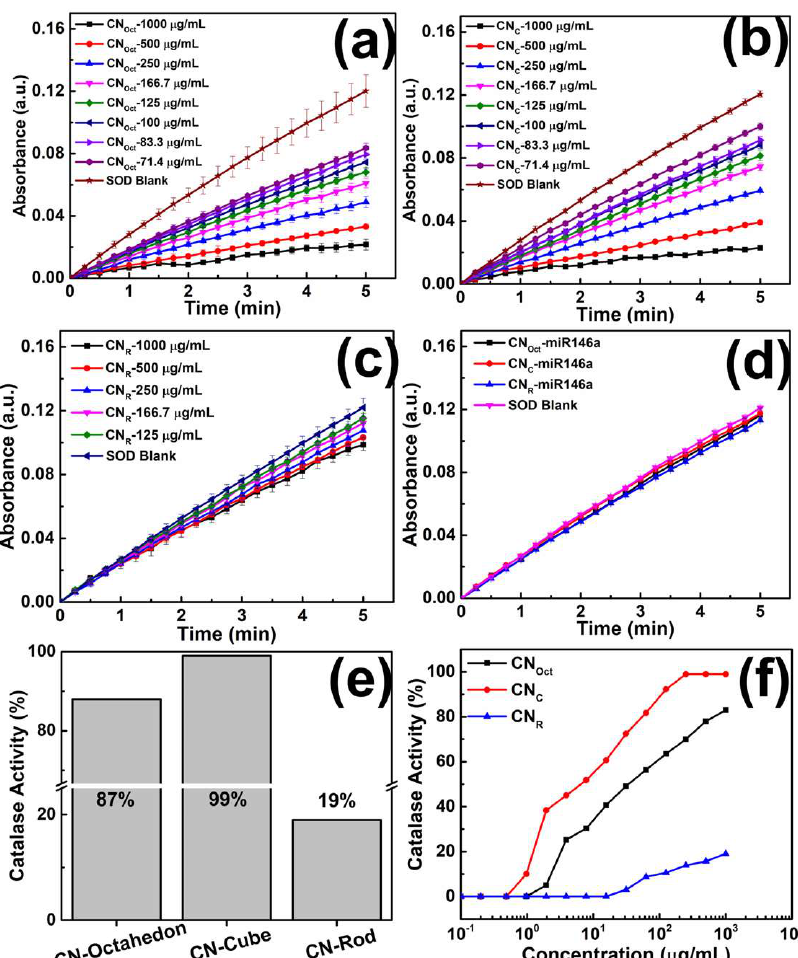
Figure 4. Superoxide dismutase (SOD) mimetic activity of CeO 2 nanoparticles with different mor- phology at different concentration. Absorbance of sample, respectively, SOD control, CN Oct , CN C , CN R , ( a – c ), respectively, and miR146a conjugated all the samples of CNPs ( d ) at 438 nm is plotted as a function of assay reaction time. Linear fitting was used to measure the slope and calculate the SOD activity. CN Oct exhibits the highest SOD activity. The miR146a conjugated CNPs showed very less SOD activity as compared to bare nanoparticles. It is due to below critical concentration of nanoparticles used for conjugation process. Additionally, the nanoparticles were losses during the purification steps using dialysis method. The catalase (CAT) assay was performed on bare and conjugated all shape of CNPs at room temperature using commercial catalase assay kit. Percentage of CAT activity calculated based on the residual H 2 O 2 concentration after 20 min of incubation with CeO 2 nanoparticles. Initial H 2 O 2 concentration was set at 2 µ M. ( e ) CAT activity of the CNPs stock solution, 1000 µ g/mL. CeO 2 -octahedra and CeO 2 cube exhibits substantial CAT activity, 87% and 99%, respectively, CeO 2 -rod exhibits mild CAT activity 19%. ( f ) CAT activity of CNPs at various concentration. Similarly, miR146a conjugated all shape of CNPs did not show the CAT activity due to the less concentration of nanoparticles present in the conjugated samples. As the SOD and CAT assay indicated that CNPs sample with concentration lower than 10 µ g/mL would not show significant SOD or CAT activity, respectively, in present assay, none of the miR146a conjugates CNPs sample (1–6 µ g/mL) show detectable SOD activity in the assay. Many of the theoretical and experimental study shows that the surface Ce 3+ /Ce 4+ ratio in CNPs is highly related to its enzymatic activity as it may act as a catalytically active site [21,22]. In general, CNPs with high Ce 3+ on the surface favor SOD mimic activity while CNPs with high Ce 4+ on the surface favor CAT mimic activity [22].